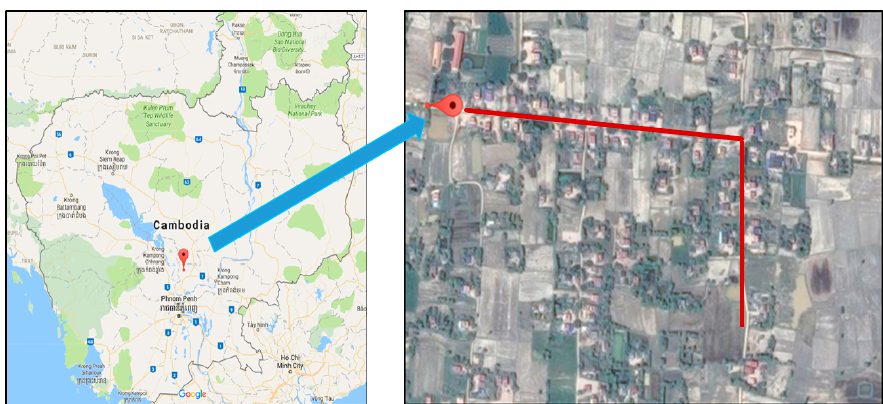
Figure 4. Test of low voltage distribution system in a rural village.